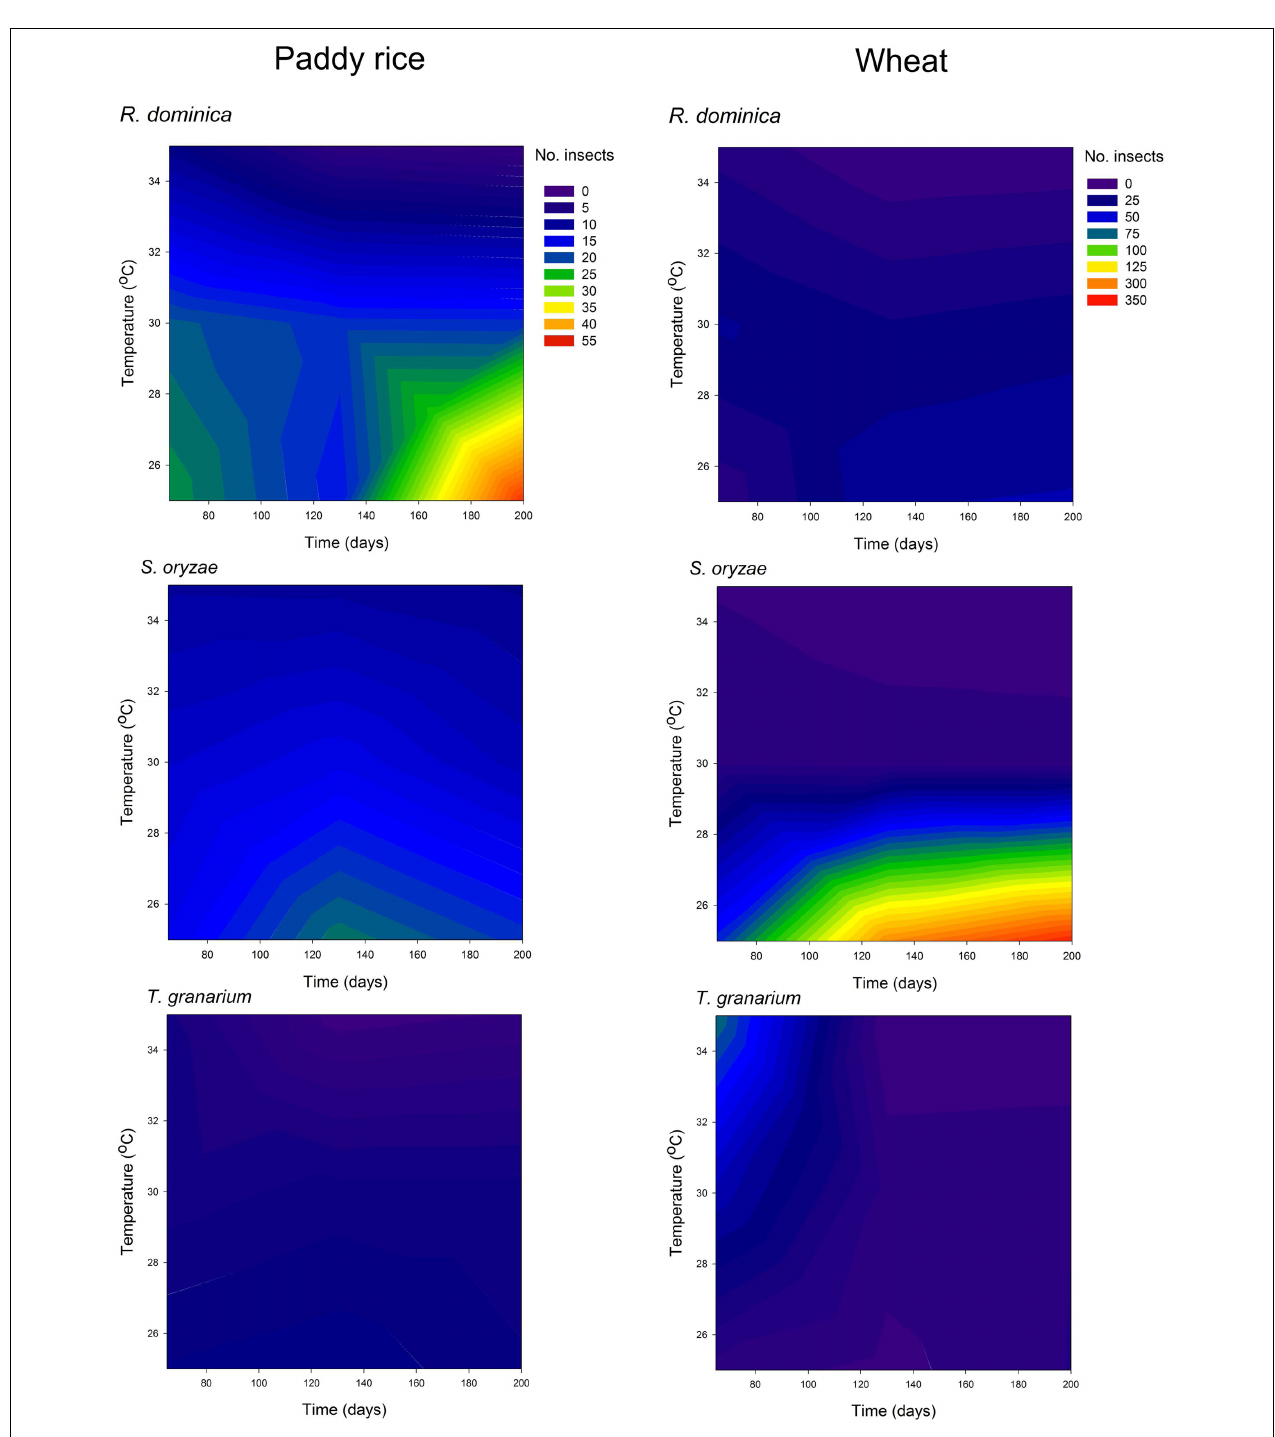
FIGURE 7 | Filled contour plots exhibiting the effect of storage time and temperature on the adult population of three competing species in grains of two cereal host species, paddy rice and